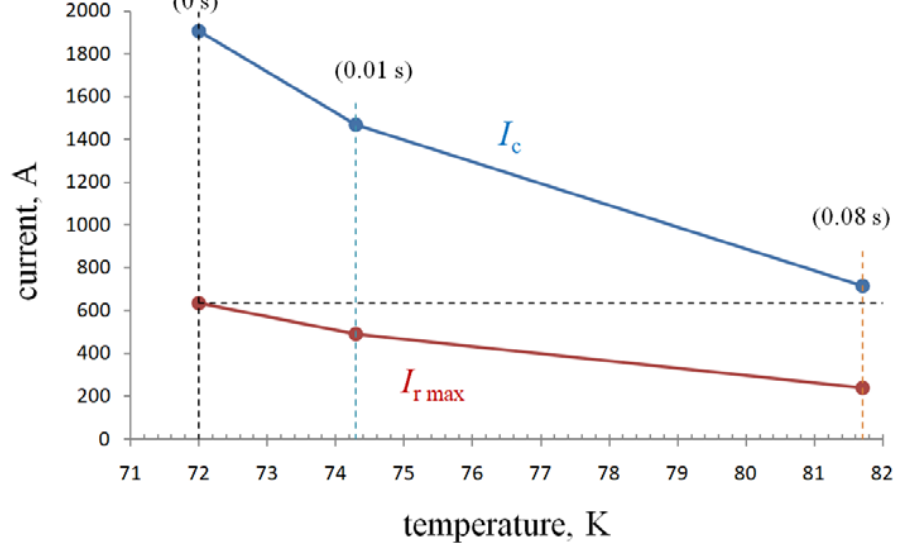
Figure 17. Basic parameters of the limiter— I c and I r max before short-circuit (0 s) and after short- circuits lasting: 0.01 s and 0.08 s, in accordance with Table 8.